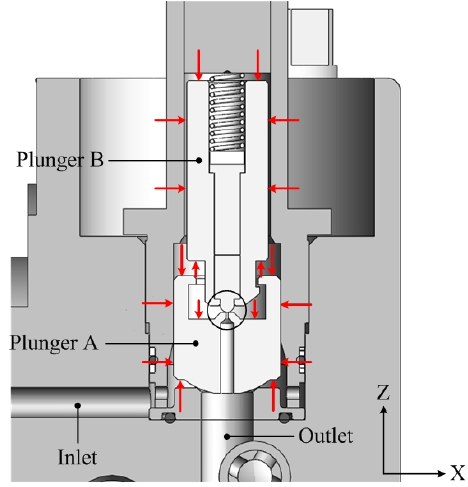
Figure 2. Distribution of pressure at initial state.